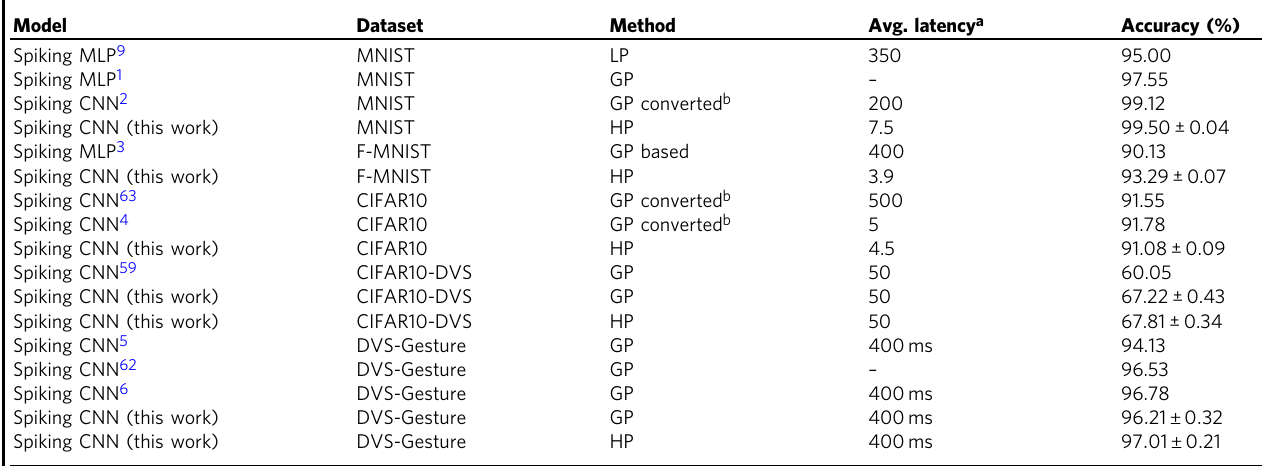
The results of the proposed models in this work collected from ten repeated runs and ± indicates the 95% con fi dence interval. a Results from the training time steps or windows reported in the published work. b Converted from a pre-trained GP-based